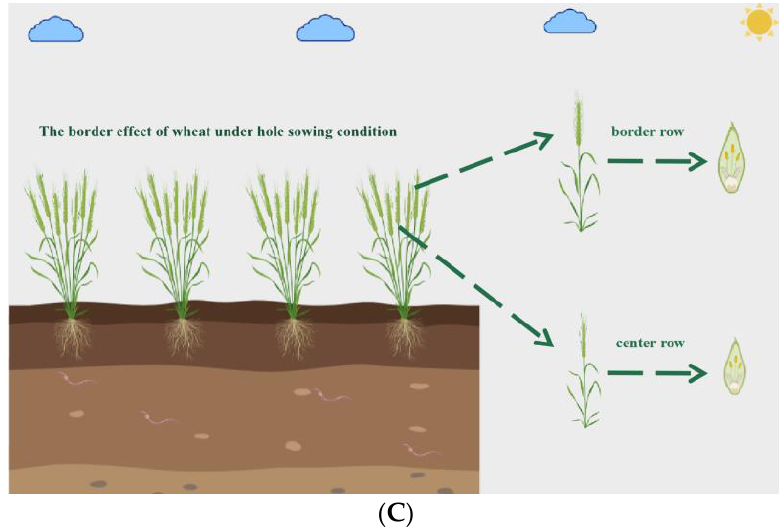
Figure 2. Hole sowing planting map of one plot ( A ), hole sowing wheat growth map ( B ), and the border effect map of wheat ( C ).